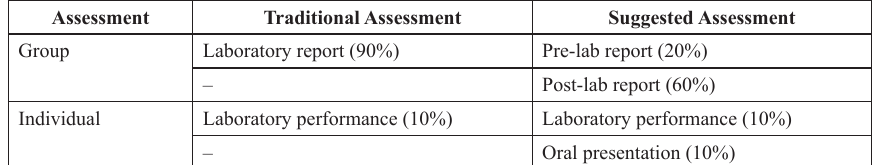
Table 7. Experiment suggested